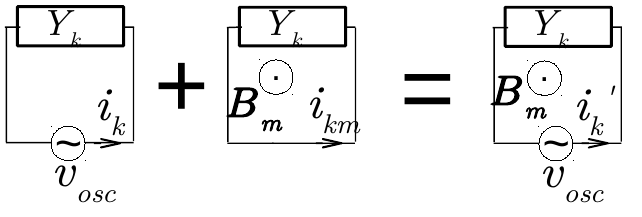
in the circuit of channel k comprises a contribution i k under study and another i k m